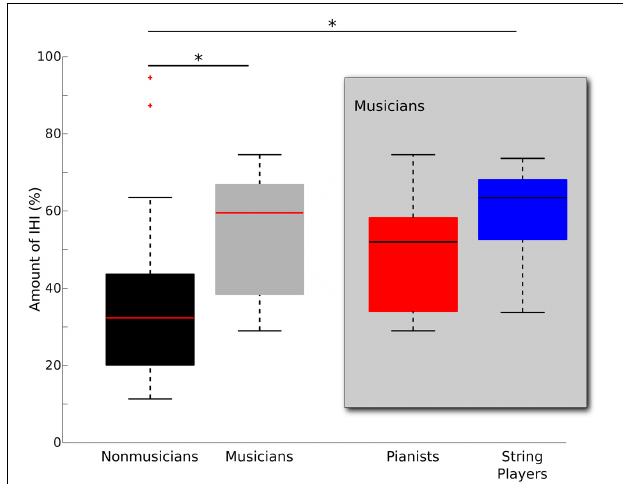
FIGURE 1 | Median boxplot of group differences in IHI from left to right M1 between musicians (gray) and non-musicians (black). On each box, the horizontal line represents the median, the upper and lower edges the 75th and 25th percentile, the whiskers show the range, and red “ + ”s indicate statistical outliers. Musicians were subdivided into pianists ( n = 7) and string players ( n = 8) and plotted separately within the gray box. Significant group differences are denoted with ∗ ( p < 0 . 05, corrected for multiple comparisons).